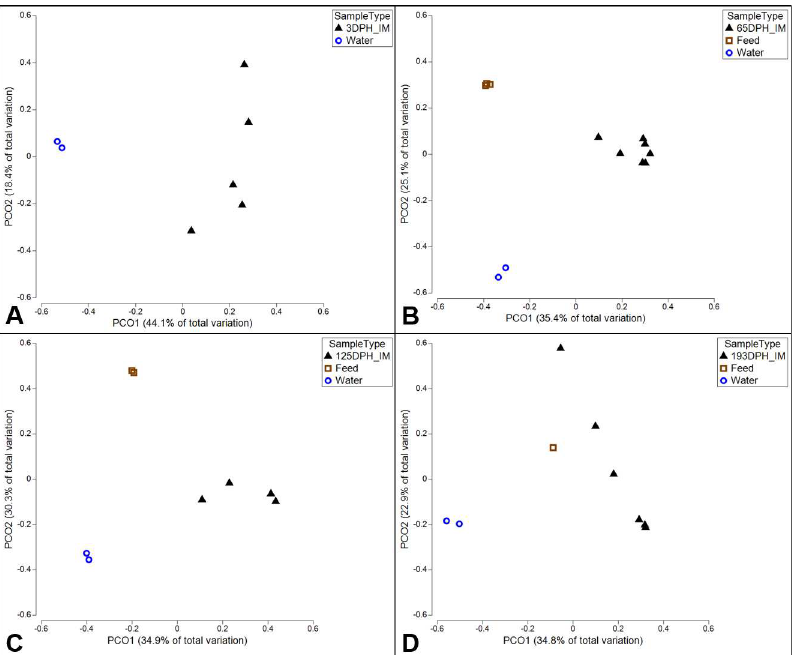
Fig 5. PCoA plots of unweighted UniFrac comparing the intestinal microbiota of channel catfish to that of environmental samples at each time point samples. At all time points, the water microbiota is represented by two replicatesamples taken at the end of the trial (193 dph) from the inflowingwater supplied to the culture tank. (A) At 3 dph the larvalsac-fry had not received any exogenous diets, so environmental comparisons are restricted to the replicatewater-supply samples. At 65 dph (B), 125 dph (C), and 193 dph (D) the catfish gut microbiota samplesare compared to the replicatewater supply samples, as well as the microbiotaof all diets uniqueto that time